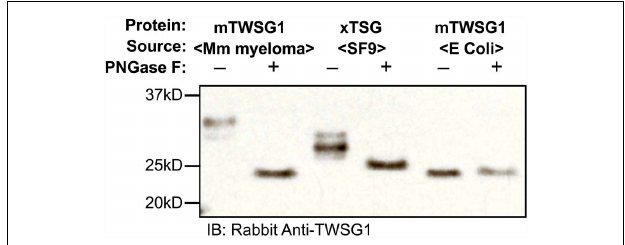
FIGURE 4 |TWSG1 glycosylation varies depending on host source. mTWSG1 made in murine myeloma cells is markedly glycosylated as indicated by the increase in mobility with PNGase F treatment. Xenopus Tsg made in insect cells is also glycosylated but shows a smaller mobility shift. MurineTWSG1 made in E. coli is not glycosylated and shows no shift in mobility after treatment with PNGase